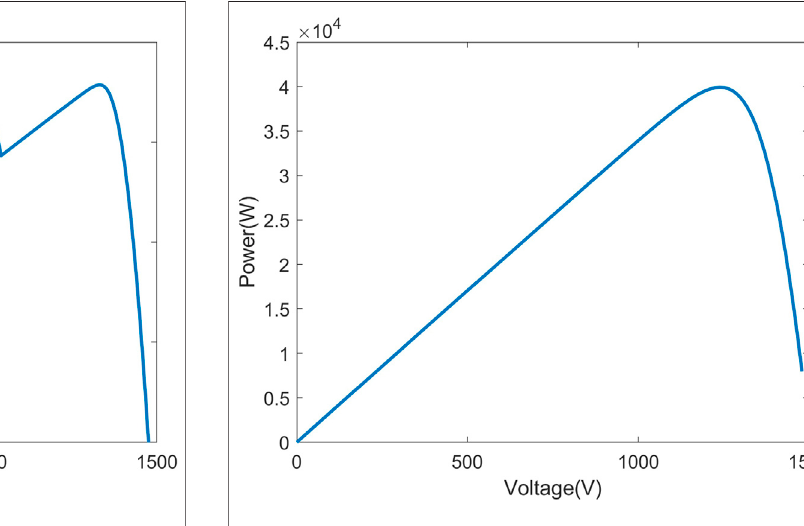
FIGURE 14 | PV curve for irridiation 4. FIGURE 13 | PV curve for irridiation